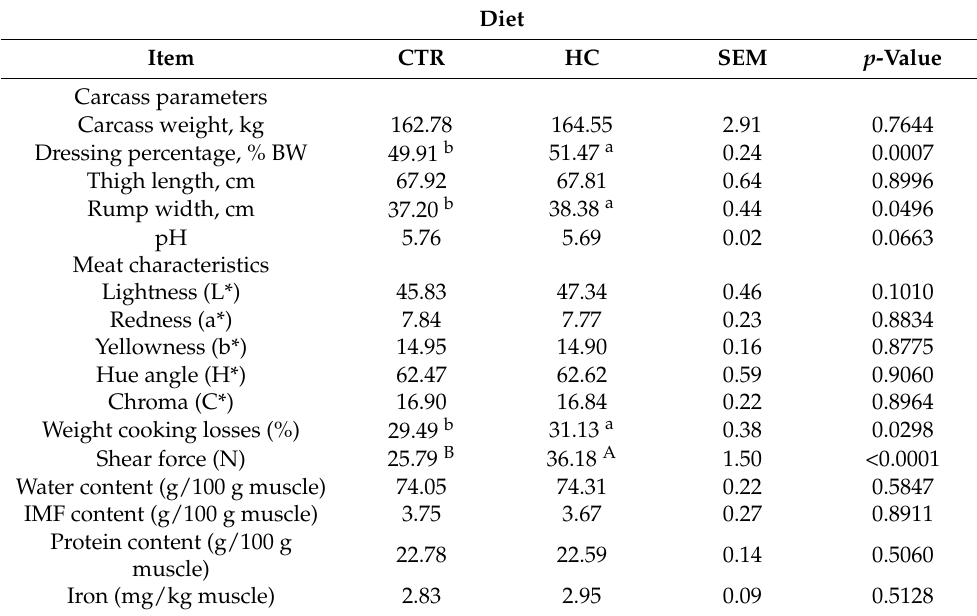
Table 5. Effect of dietary hemp cake supplementation on carcass traits and physicochemical properties of Longissimus dorsi muscle at 7 days of storage of Holstein veal